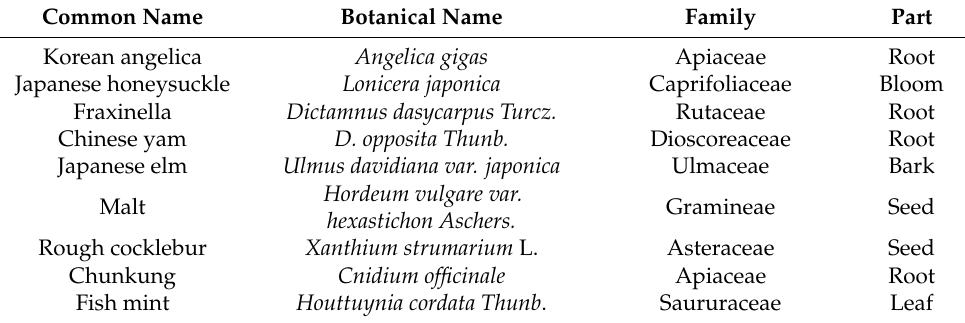
Table 2. Nine oriental medical plants used in this